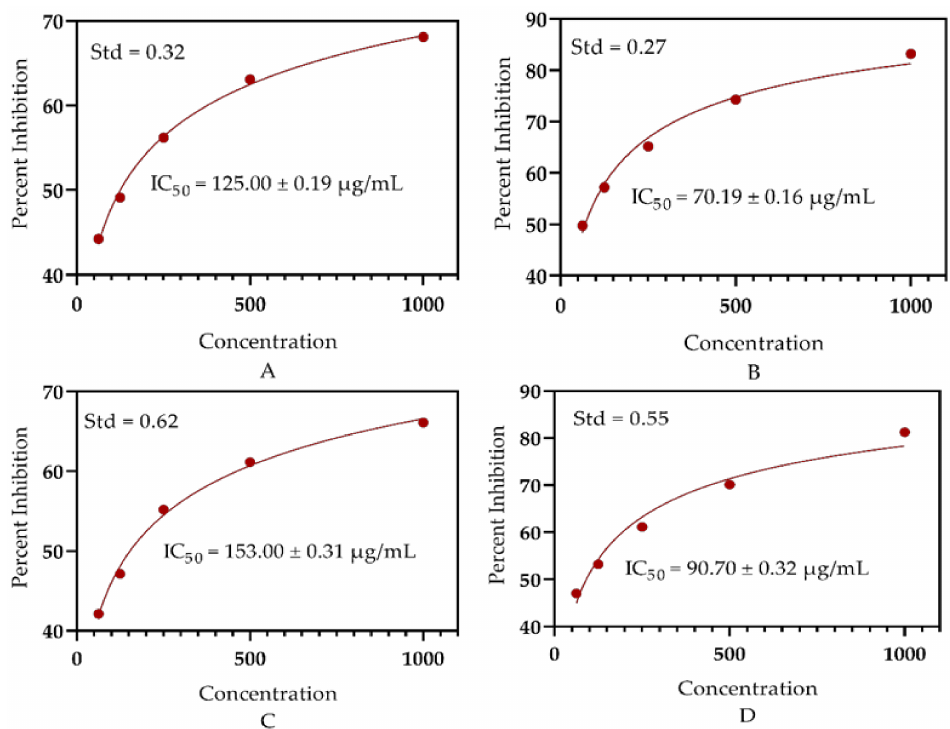
Figure 4. ( A ) antioxidant potential of the S. edelbergii essential via DPPH assay, ( B ) antioxidant activity of ascorbic acid at DPPH assay, ( C ) antioxidant activity of SEEO via ABTS assay, ( D ) free radicals scavenging effect of ascorbic acid via ABTS assay, (Std) standard